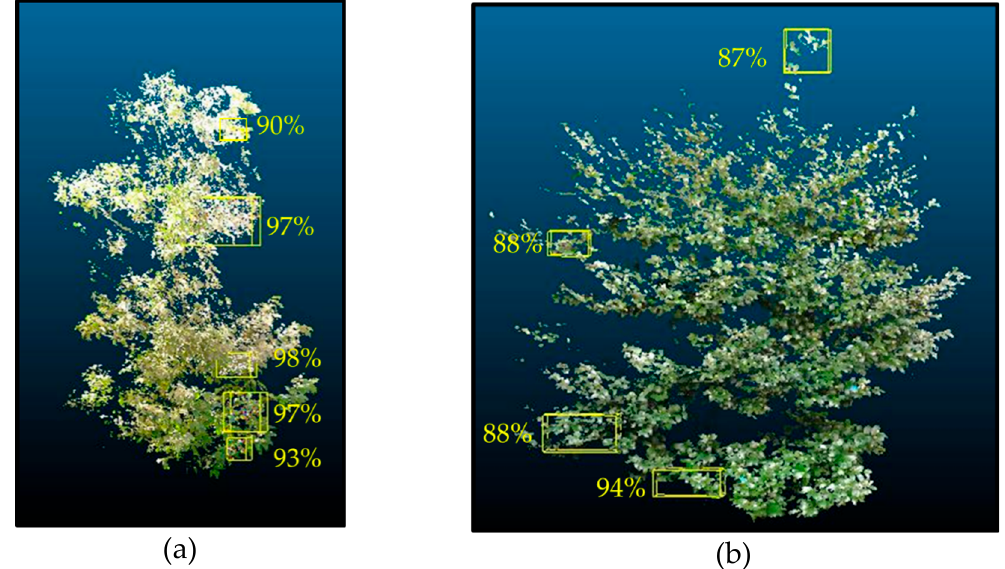
Figure 7. Randomly extracted samples for the validation of leaf segmentation in ( a ) the mochi tree and ( b ) the Japanese camellia.